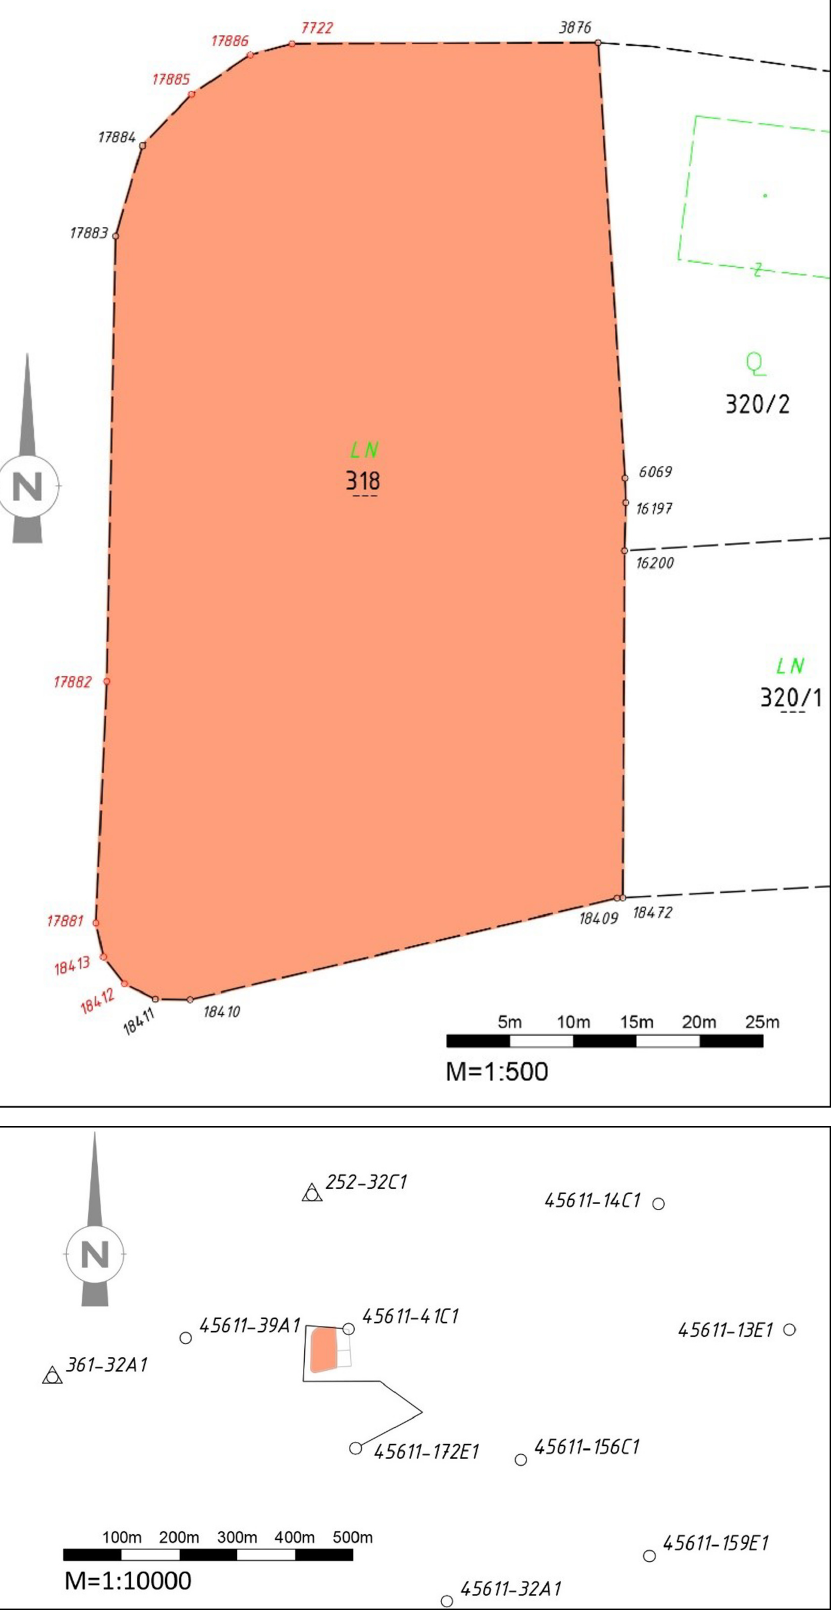
Figure 4. Cadastral maps showing the affected parcel. Boundary marks that have been found in the real world are plotted in red ( top ). Overview of the control point network including the traverse used to survey the parcel ( bottom